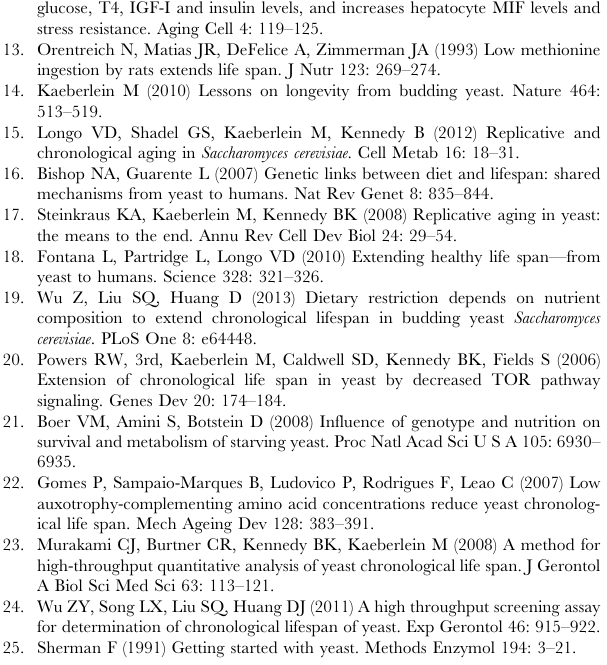
different lowercase letters in columns indicate significant differ- ence. Data expressed as mean 6 s.d (n= 3). (TIF) Figure S7 Comparative evaluation of the amino acid induced longevity in different single gene deletion strains. ( A ) Survival curves of gcn2 D , sir2 D , sod2 D , and tor1 D were cultured in 1E1N or 1E5N with 2% glucose medium. ( B ) Survival curves of gcn2 D , sch9 D , sod2 D , and tor1 D were grown in different media with high glutamic acid (20 6 Glu) or low methionine (0.1 6 Met). ( C ) Survival curves of gcn2 D , and sch9 D were grown in different media with/without the combination of glutamic acid and methionine (0.1 6 Met + 20 6 Glu). Survival curve are the mean of six parallel measurements. The statistical analysis of significant difference for the CLS comparison is presented in Figure 7 . (TIF) Figure S8 The acetic acid production of aging media in sch9 D and gcn2 D . 0.5% glucose (CR) caused lower acetic acid accumulation in aging media than 2% glucose in most cases. The acetic acid was measured at stationary phase (day 2) of yeast cultured in 1E1N (Normal) and 1E5N media without (control) or with low methionine (0.1 6 Met), high glutamic acid (20 6 Glu) or a combination of both (0.1 6 Met + 20 6 Glu). Data are expressed as mean 6 s.d. (n= 3).